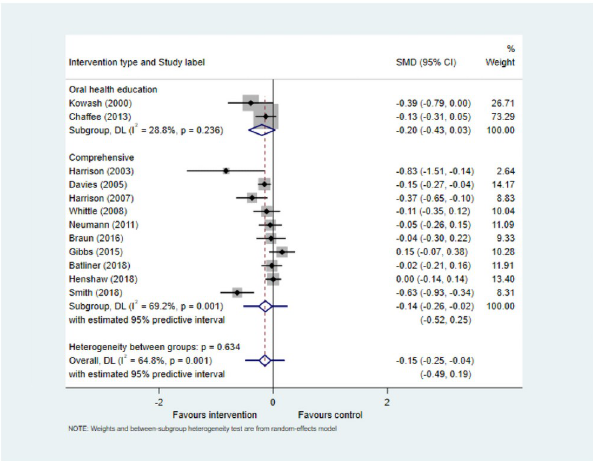
Fig 2. Forest plot for studies reporting caries experience as